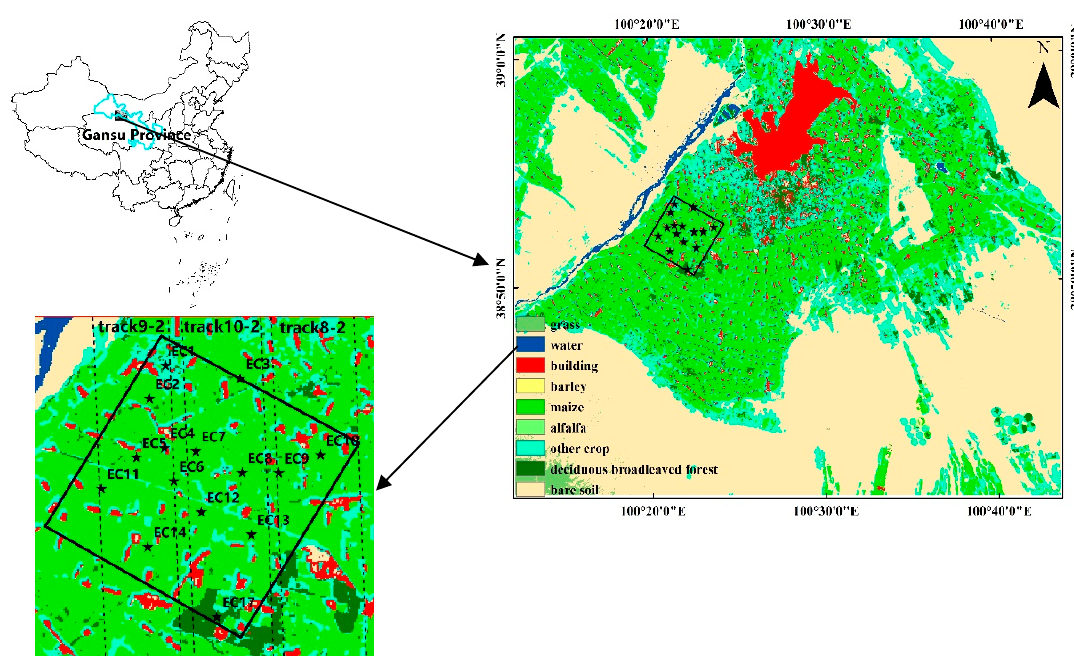
Figure 1. Geographic location and land cover map of the study area. The land use map was obtained from a monthly land cover map data base of the Heihe River Basin [25]. The map in the lower left contains the approximate locations of the eddy covariance (EC) towers used in the validation of the TSEB fluxes and were deployed within the main experimental domain (rectangular box; EC1 indicated the first EC tower, and so on). The aircraft imagery was collected over portions of the study area, and its spatial coverage is indicated by the dash lines.